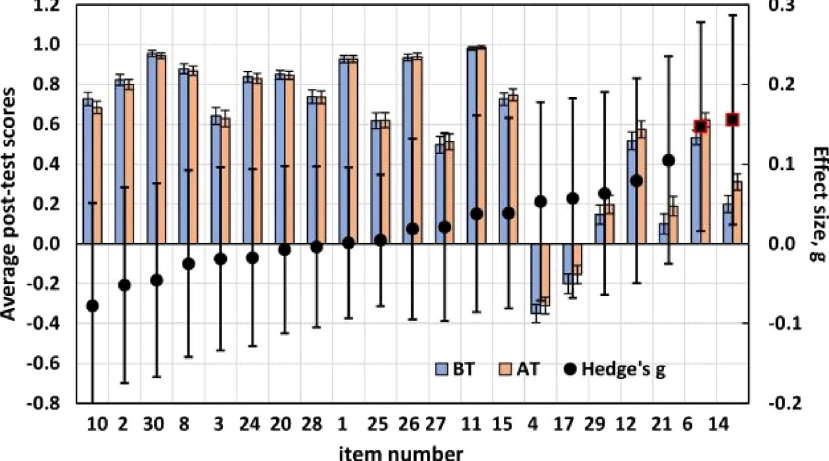
FIG. 7. Men ’ s average post-test scores in the BT (blue) and AT (orange) courses on E-CLASS items (bar graph) that are not related to the AT course learning goals. Effect sizes, Hedge ’ s g and the corresponding 95% confidence intervals, are plotted as symbols for each of the items. Items with significant differences between BT and AT post-test scores for men are denoted by